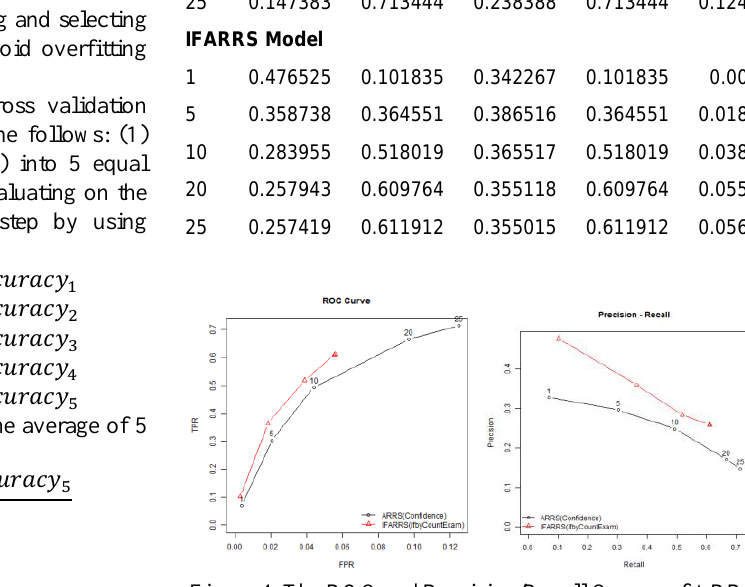
Figure 4. The ROC and Precision/Recall Curves of ARRS and